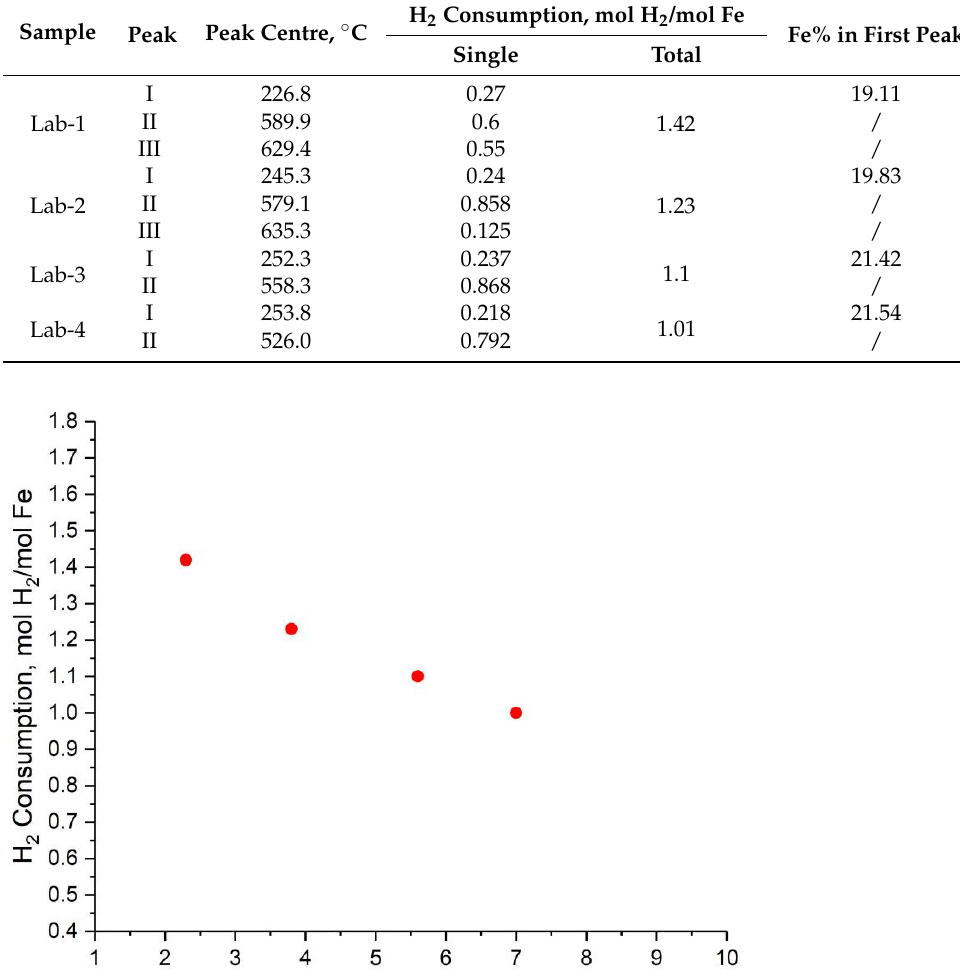
Table 1. Quantitative results of H 2 consumption for the catalysts in the H 2 -TPR procedure.